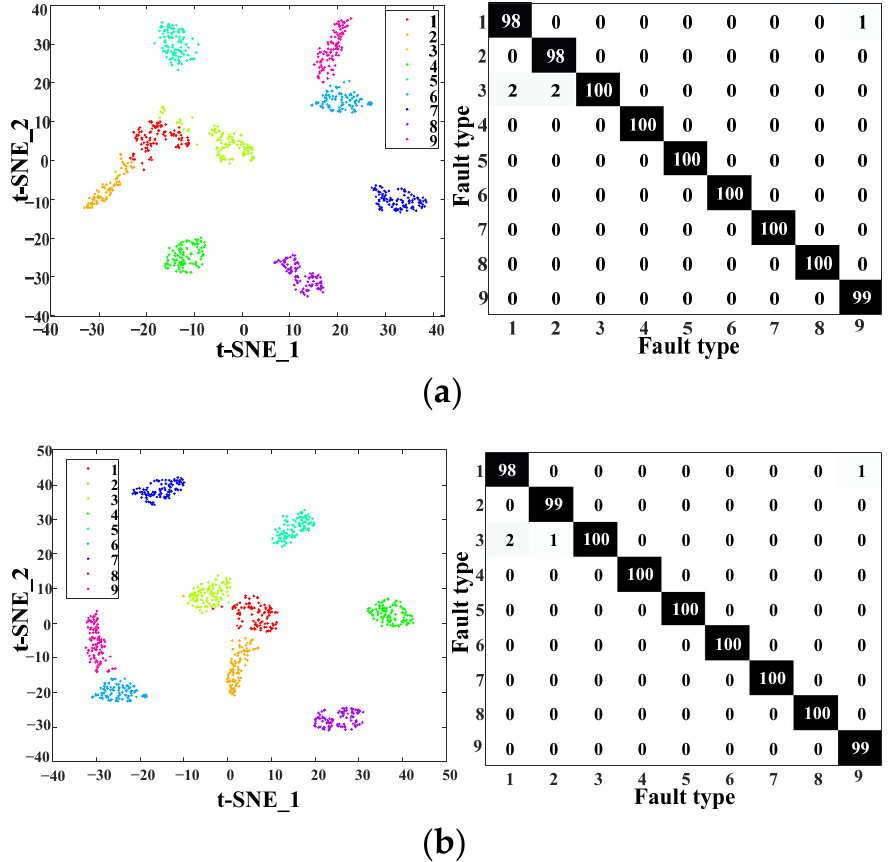
Figure 7. ( a ) Visualization and prediction error matrix of RESNET ( b ) Visualization and prediction error matrix of SDGD-RESNET. The convergence speed of the proposed algorithm (green line) is significantly better than that of the common RESNET diagnosis method, denoted as the purple line. Corre- spondingly, the diagnostic accuracy of the proposed algorithm (red line) improved faster than that of the common RESNET method, denoted as the blue line. With larger batchsize settings, as illustrated in Figure 8d, the network’s accuracy improves significantly faster than the conventional networks. Moreover, Table 4 demonstrates that SDGD-RESNET outperforms RESNET by a maximum of 14.89% in the impact on convergence speed, which shows that SDGD-RESNET is better than RESNET on convergence performance while maintaining a comparable diagnostic accuracy to RESNET. Table 4. Convergence speed